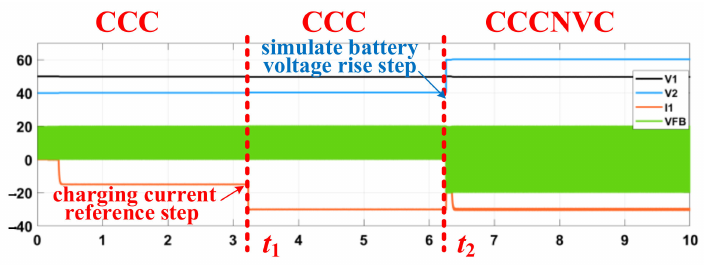
Figure 9. Waveforms in charging state.